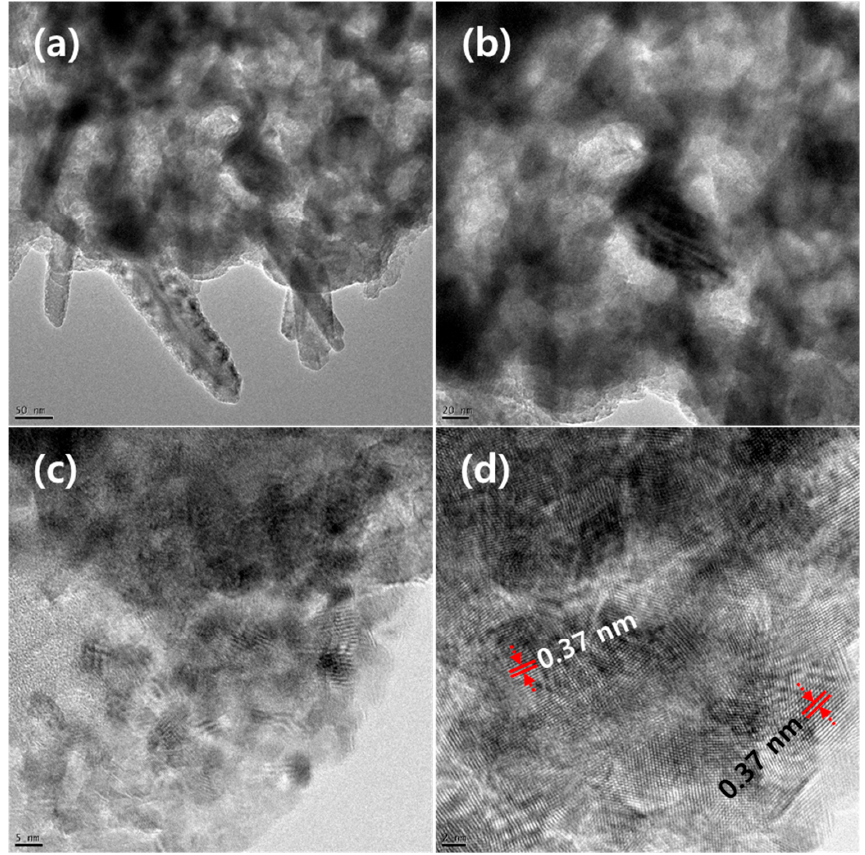
Figure 2. ( a , b ) TEM and ( c , d ) HRTEM images with different magnifications of the prepared ATC. The X-ray diffraction (XRD) and Raman spectroscopy analyses were performed to study the crystallinity/graphitization of the obtained ATC. In Figure 3a, the XRD spectrum reveals two distinct, intense peaks centered at the incidence angle (2 θ =) 24° and 43°, indi- cating the formation of (002) and (100) crystal planes, respectively, corresponding to the characteristic peaks of graphitic carbon [34]. Moreover, the evaluation of the (002) peaks for determining the interplanar distance between the carbon lattice plane was performed using the Debye–Scherrer equation; and the value was calculated to be 0.37 nm. It was interesting to note that this theoretical value well coincides with the value (0.37 nm) ob- tained from HRTEM. Notably, this value seems to be higher when compared to the con- ventional graphene interplanar value of 0.34 nm. This variation in this value could be at- tributable to the fact that the doping of various heteroatom in the framework of carbon and the existence of functional groups on the surface can alter the interplanar spacing in the form of defects and deformations in carbon lattice planes. This assumption could be justified by the observations obtained from FESEM elemental mapping. Moreover, there are more chances for the occurrence of carbon surface oxidation that can eventually lead to the formation of partial amorphous coatings over ATC, which could also be a possible